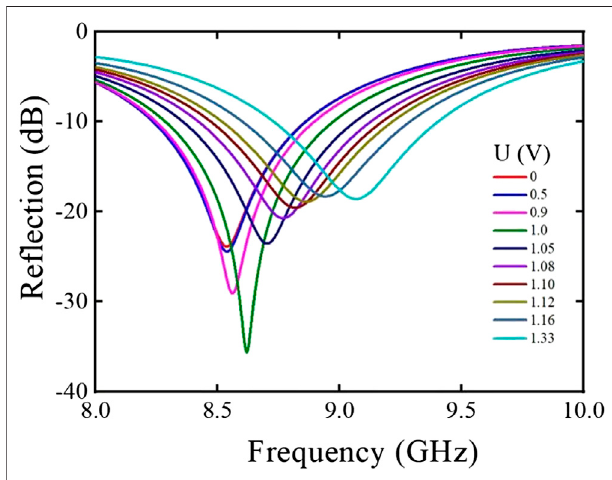
FIGURE 6 | The measured re fl ection spectra when bias voltage varies from 0 to +1.33